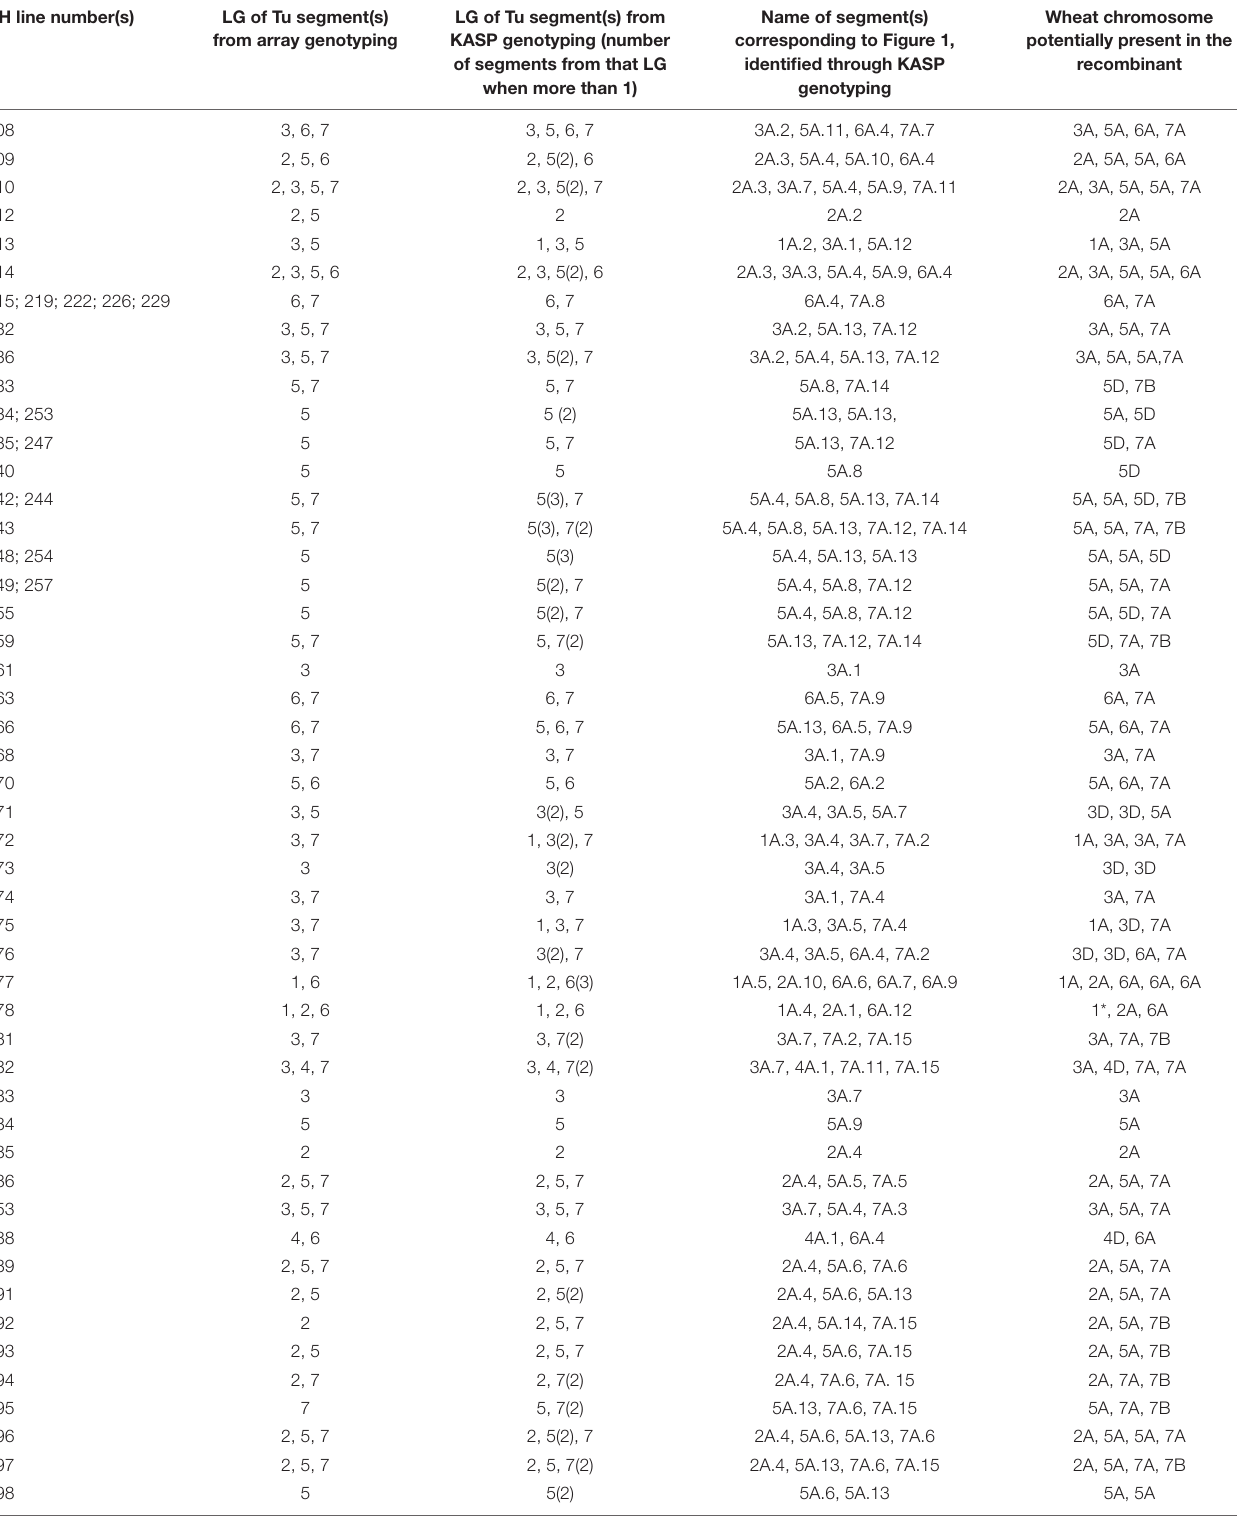
TABLE 2 | List of all 86 wheat- T. urartu DH lines showing the linkage groups detected in each line via the Axiom array and KASP markers and the name of the unique introgression (corresponding to Figure 1 ) and its potential location in the wheat genome. DH line number(s) LG of Tu segment(s) LG of Tu segment(s) from Name of segment(s) from array genotyping KASP genotyping (number corresponding to Figure of segments from that LG when more than 1)